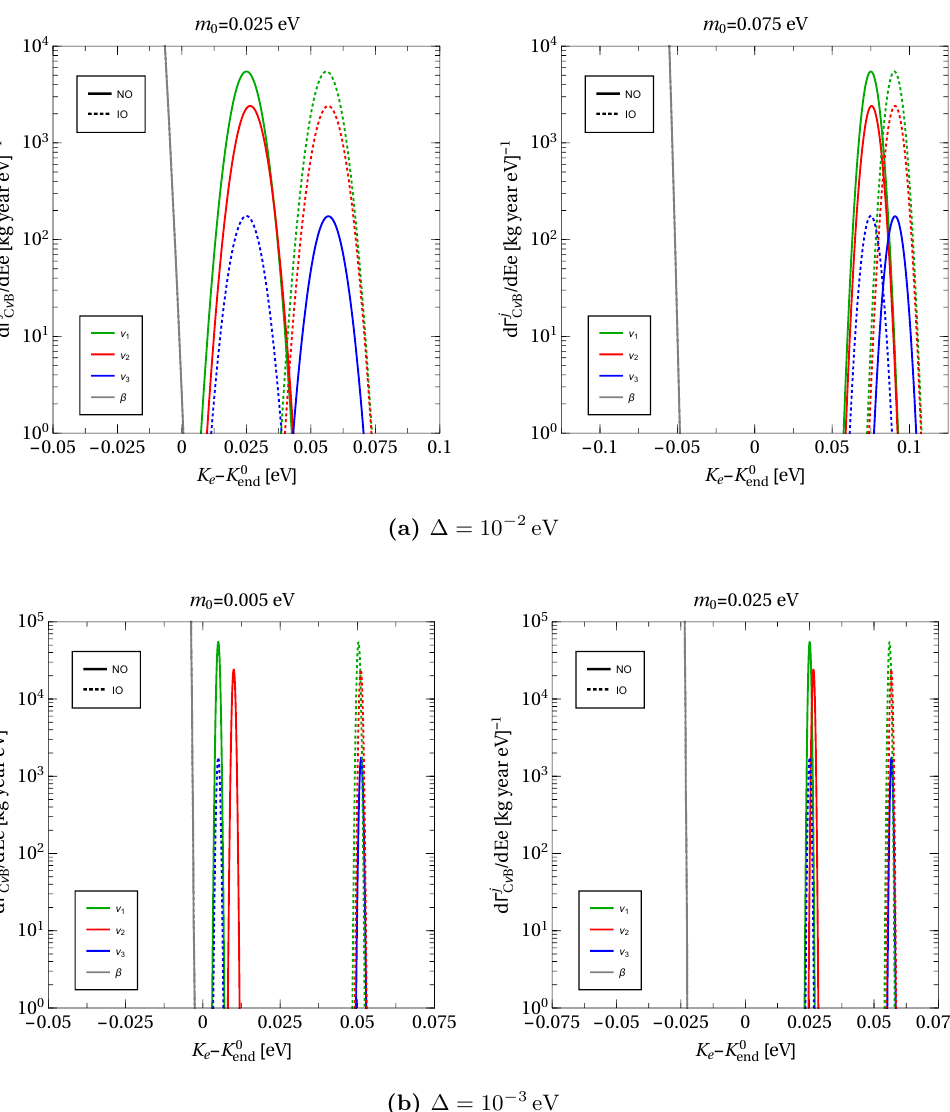
Figure 4. Simulated spectra of the electrons created by the relic neutrino capture for (cid:1) = 0 : 01 eV (upper panels) and (cid:1) = 0 : 001 eV (lower panels) for each mass eigenstate contribution: (cid:23) 1 (green), (cid:23) 2 (red), (cid:23) 3 (blue). A few values of the lowest neutrino mass m 0 are considered to illustrate the behavior for the normal ordering (NO) and inverted ordering (IO). The gray line corresponds to the endpoint of the (cid:12) -decay background.